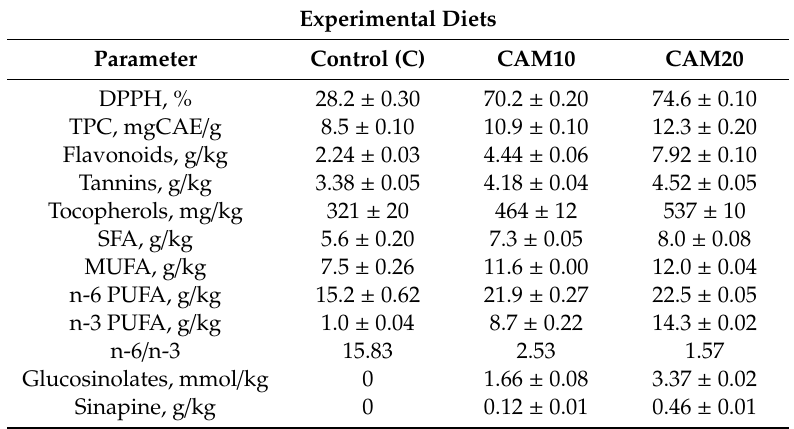
Table 3. Antioxidant capacity (DPPH), total phenolic compounds (TPC), flavonoids, tannins, tocopherol content, fatty acid composition, and antinutritional compounds (mean value ± SE) of the experimental diets. Control = corn-soybean meal basal diet; CAM10 = basal diet containing camelina cake at 10%; CAM20 = basal diet containing camelina cake at